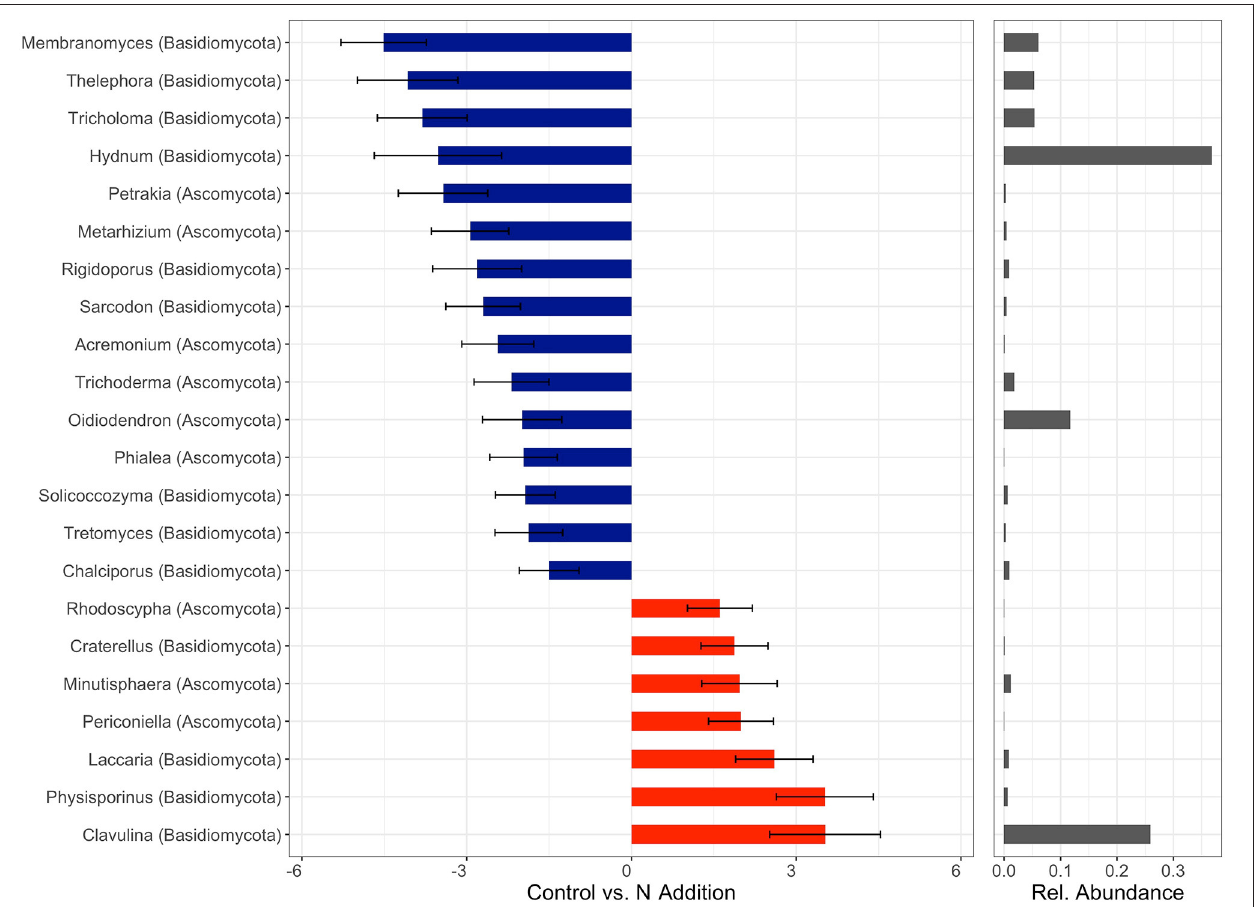
FIGURE 6 | Differently abundant fungal genera (statistically different p < 0.05) which respond to N treatments across all soil horizons with a log 2 -fold change > 1.0. Negative values (blue) refer to Control-upregulated genera, positive values (red) to N-Addition-upregulated genera. Bar diagrams on the right shows the relative